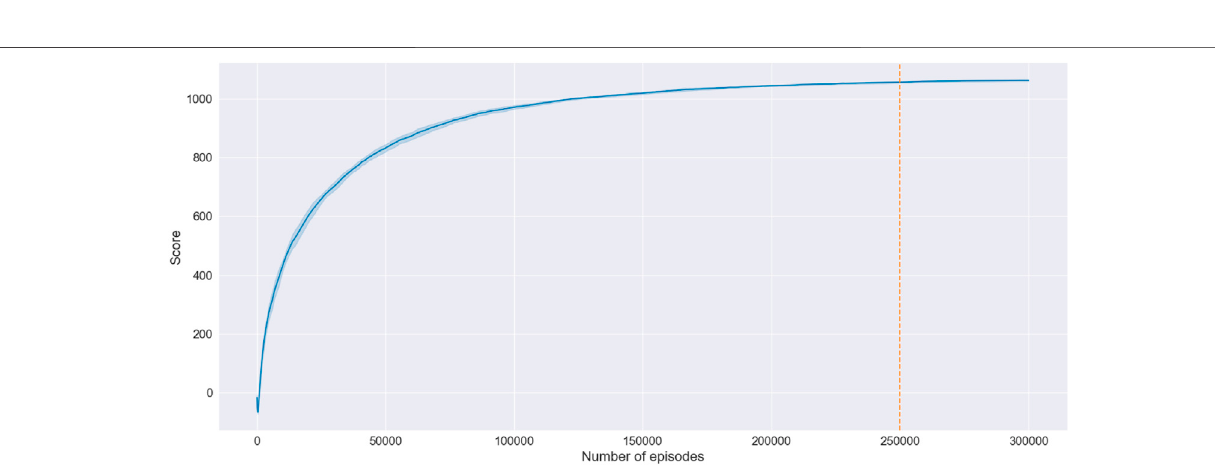
Frontiers in Big Data |